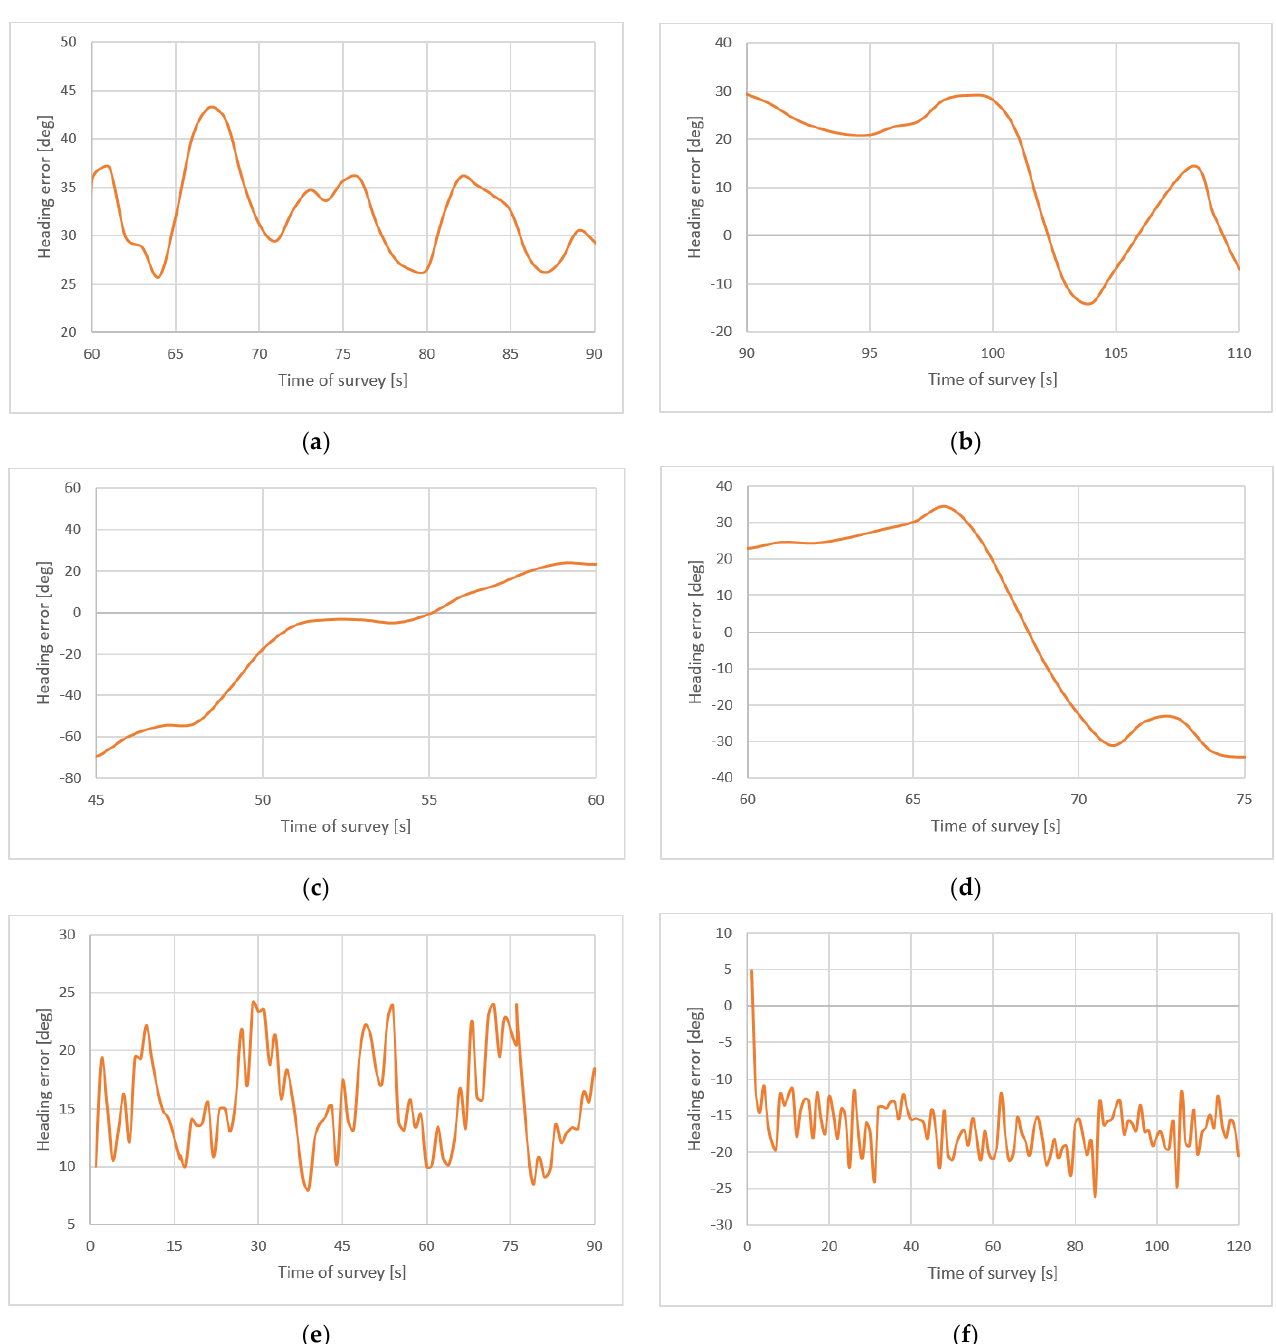
Figure 15. Heading differences between satellite compass and fluxgate during surveys: long profile ( a ) and turning ( b ), short profile ( c ), quick heading changes ( d ), and circulations right ( e ) and left ( f ).